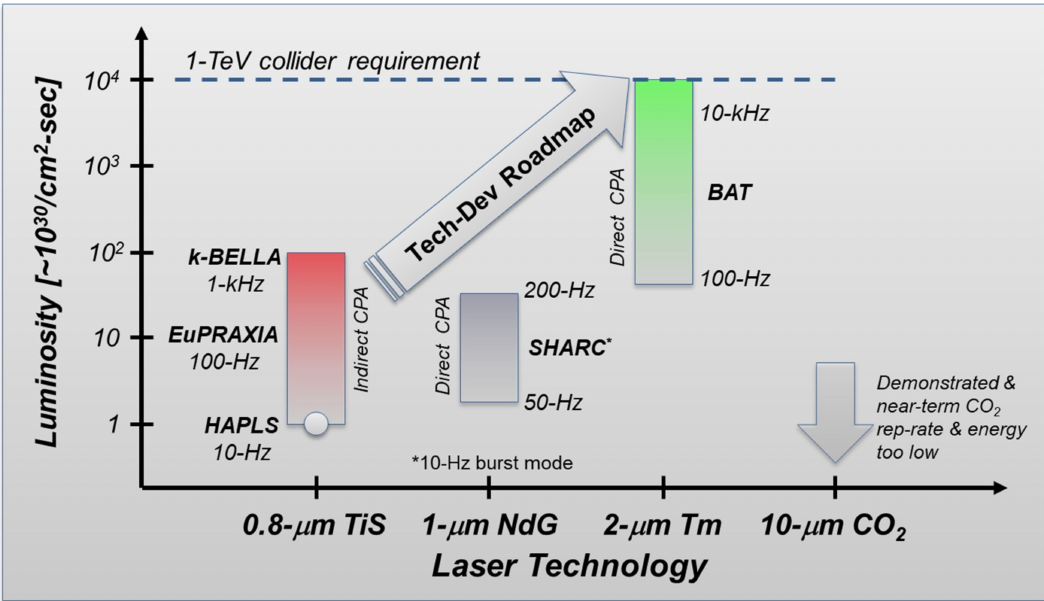
Figure 2. Collision luminosities scaling for current and proposed LWFA drive lasers. TiS and NdG (Nd:glass) lasers can be scaled in rep-rate to ~kHz and 0.2-kHz, respectively, and so are at best near-term stepping stones towards the 10 34 / cm 2 -sec luminosity goal for a future TeV-scale collider. Multi-pulse extraction lasers based upon Tm:YLF (BAT) can scale to 10’s of kHz necessary to meet this